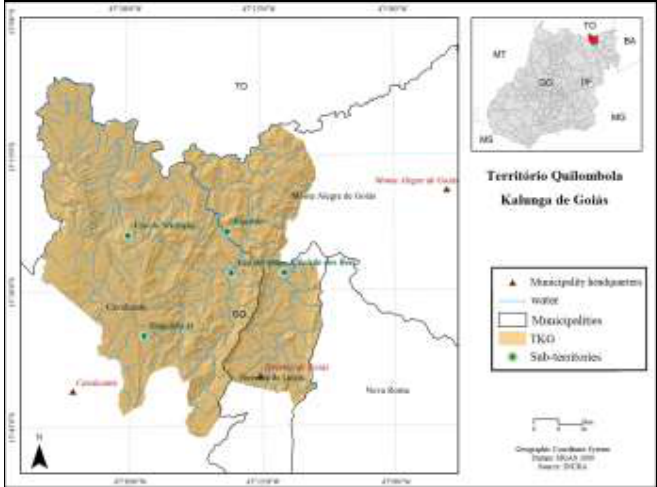
Figure 1. Location of the TKG.